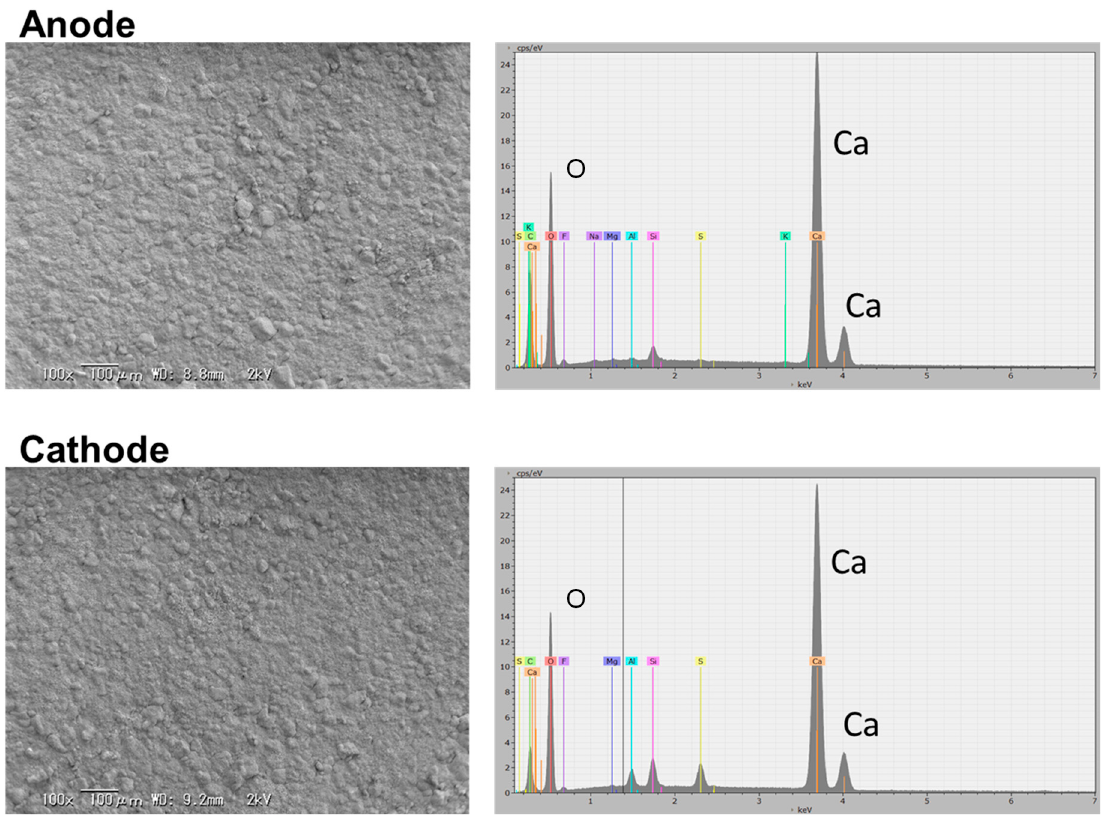
Figure 5. SEM images and EDX element analysis of the sample surfaces at the anode and cathode sides after cell polarization for 60 h. Cell polarization was conducted in humidified air at 70 °C.